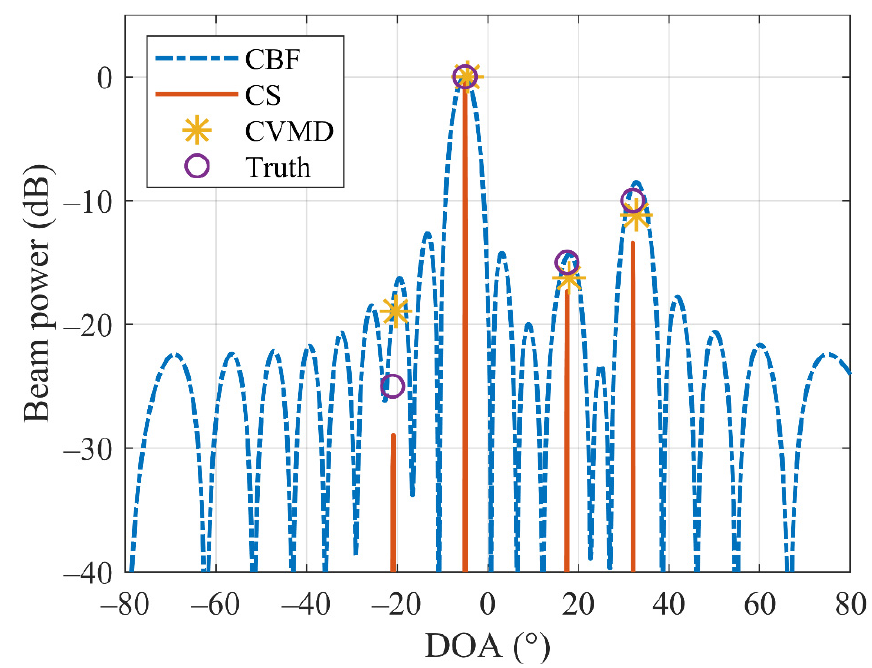
Figure 3. DOA estimation for four sources at − 21° with SNR = 5 dB, − 5° with SNR = 30 dB, 17.5° with SNR = 15 dB, and 32° with SNR = 20 dB by CBF, CS, and CVMD method.